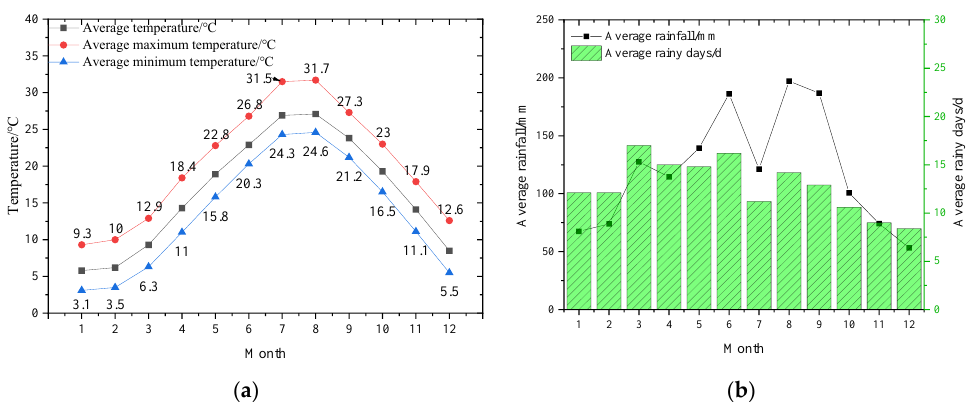
Figure 3. Climatic information for XHMB: ( a ) temperature; ( b ) rainfall.